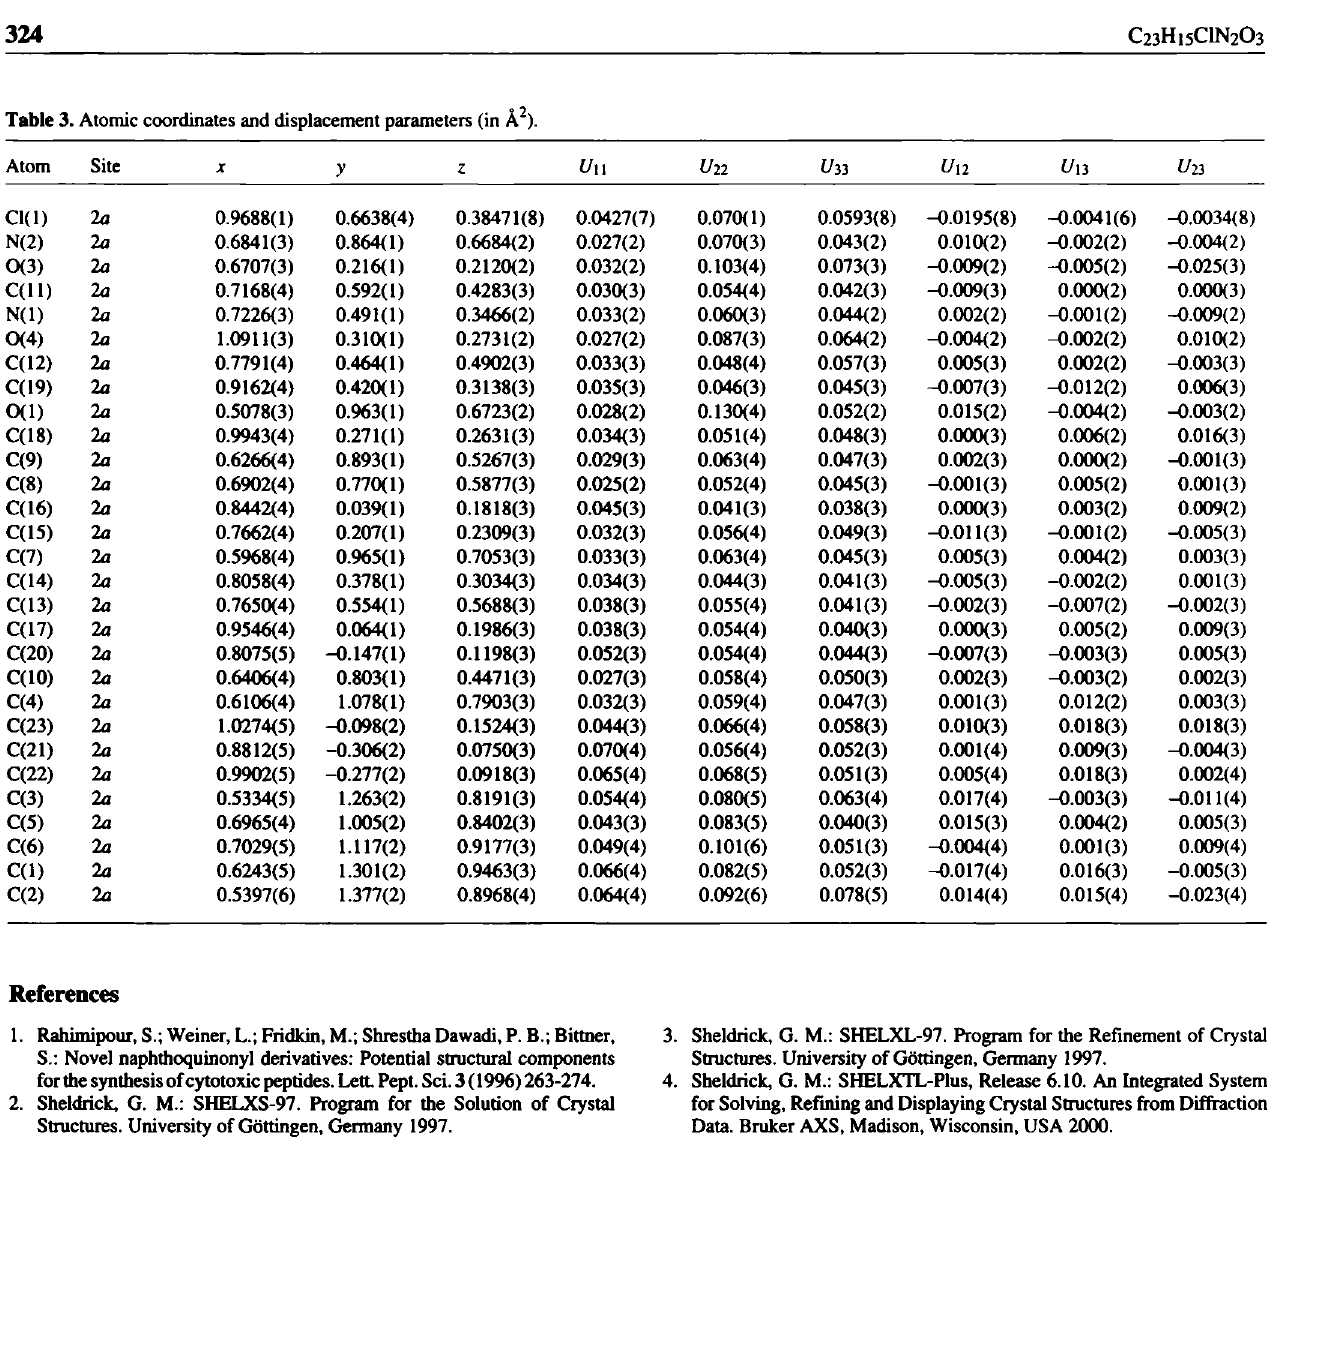
Table 3. Atomic coordinates and displacement parameters (in Â 2